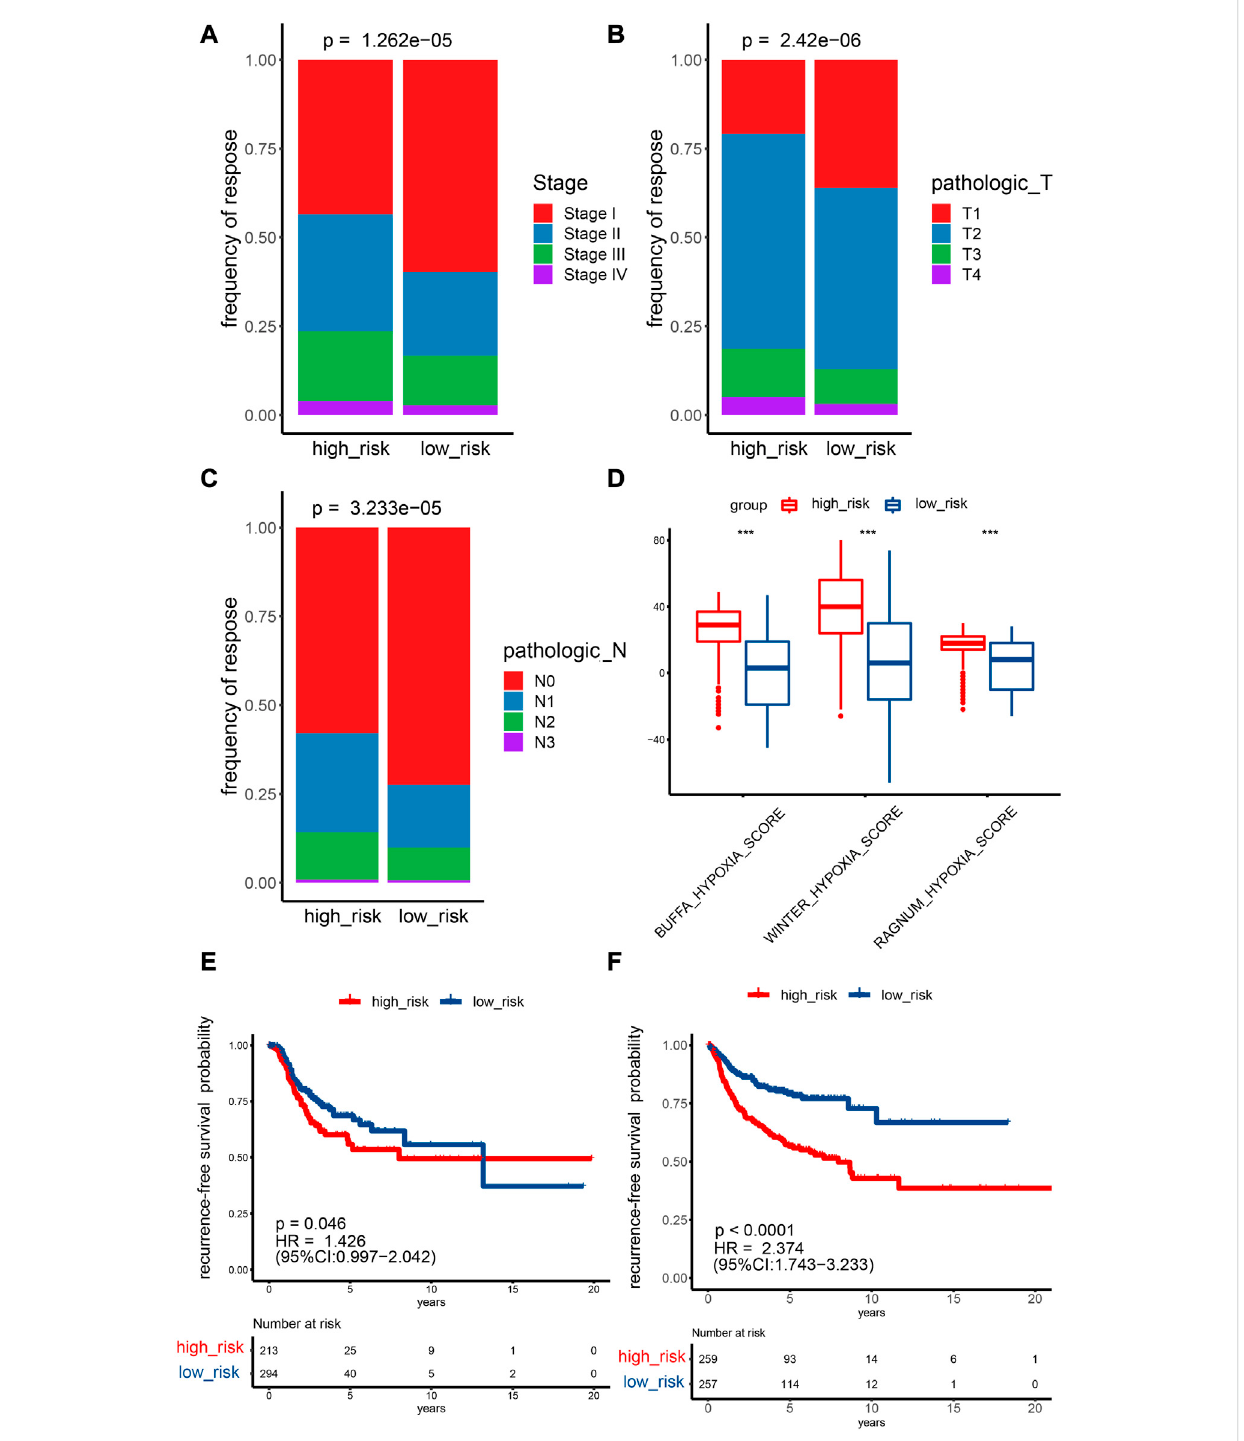
FIGURE 3 PredictionabilityoftheHRGmodelfortherecurrenceandstageofNSCLCpatients. (A – C) TCGAcohortFishertestoutcomesforTandNstagesand pathological stages comparing two risk categories. (D) Analyzing the differences between two risk categories on three known hypoxia scores. * p < 0.05; ** p < 0.01; *** p < 0.001. (E,F) Recurrence survival curves for two risk categories. E: TCGA cohort, F: GEO